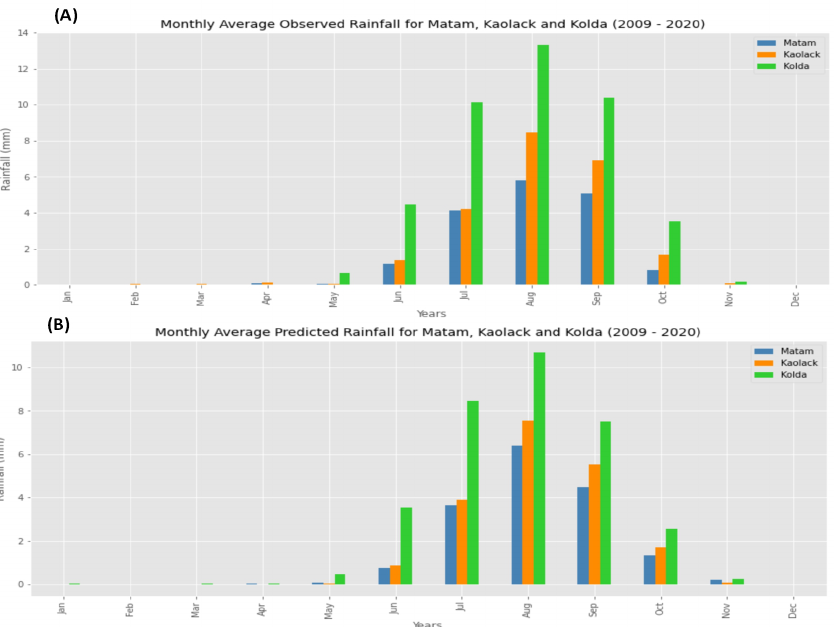
Figure 27. Monthly Average Observed and Forecasted Rainfall for Matam, Kaolack and Kolda